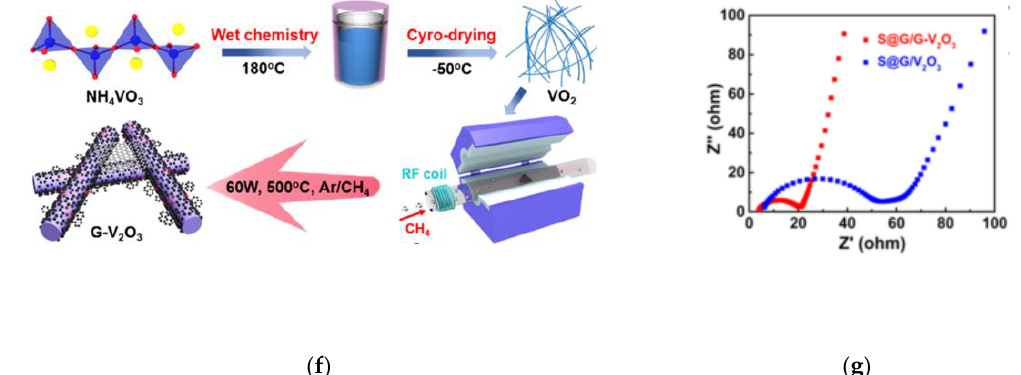
Figure 4. ( a ) CVs of the S / NiCo 2 O 4 and S / CNF composites at the scan rate of 0.1 mV s − 1 [34]. ( b ) Demonstration of the static adsorption of Li 2 S 4 on NiCo 2 O 4 nanofibers and CNFs. UV–Vis spectra of supernatant of Li 2 S 4 solution after the adsorption test, and the corresponding photos (inset) [34]. ( c ) A schematic showing the faster redox kinetics of LiPS on the NiCo 2 O 4 surface [34]. ( d ) Cyclic stability and Coulombic e ffi ciency (at 0.2 C) for sulfur impregnated in di ff erent composite cathodes as noted [35]. ( e ) E ff ective anchoring of polysulfides and promoting their conversion by Fe 3 O 4 / NC / G composites [36]. ( f ) Schematic illustration of the synthetic procedure of G-V 2 O 3 [37]. ( g ) EIS curves of S@G / G-V 2 O 3